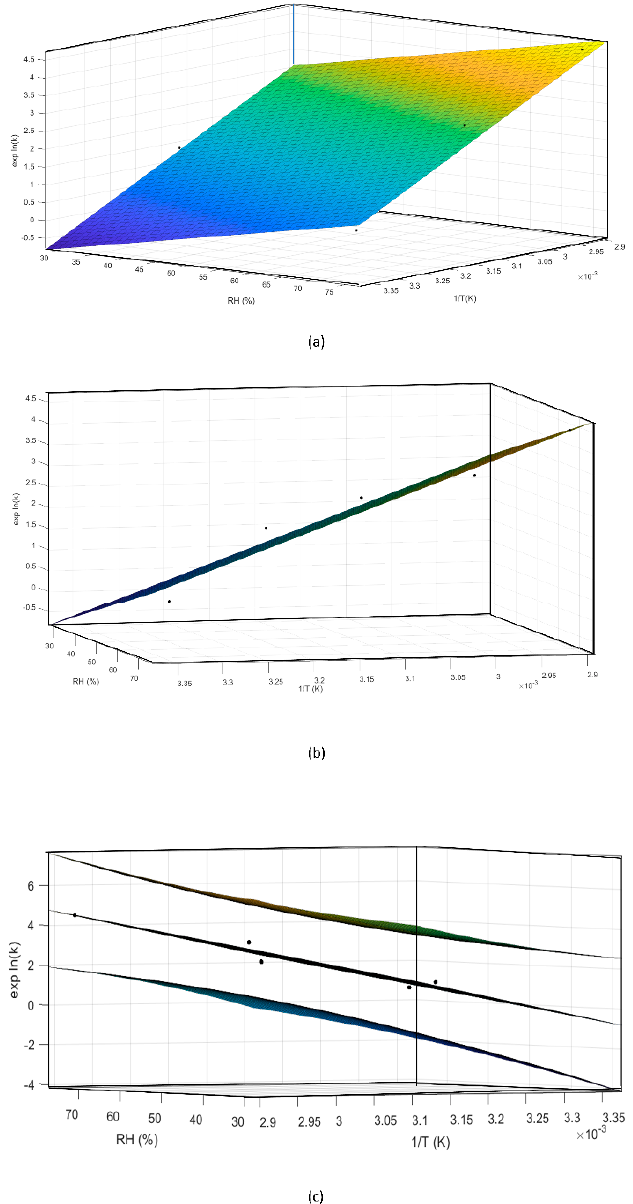
Figure 6. Different perspectives of a three-dimensional surface plot of the model generated by the Matlab curve-fitting tool ( a , b ). Using the same tool the confidence bounds for this fitting were calculated with a level of certainty of 95%, represented by the upper and lower planes ( c ).